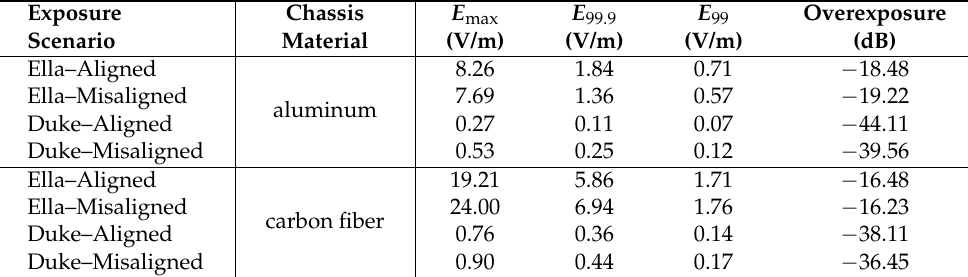
Figure 8. Induced electric field distributions inside Ella (left) and Duke (right) for the aligned ( a ) and misaligned ( b ) coil positions in the Al chassis and for the aligned ( c ) and misaligned ( d ) coil positions in the CF chassis. E norm is the logarithmic electric field normalized to the peak value. E lim is the basic restriction (BR) = 11.48 V/m (the red area is the portion where the BR is exceeded). Table 1. Summary of the compliance assessment with the BR for the considered exposure